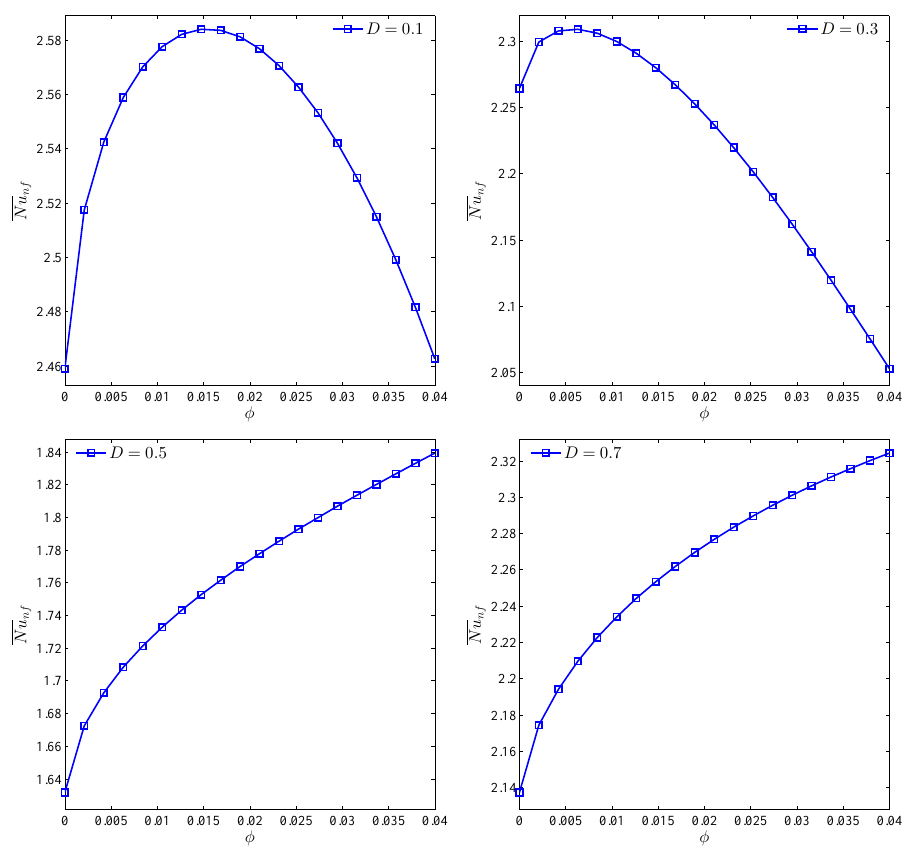
Figure 17. Variation of average Nusselt number with φ for different D at Ra = 10 4 and k w =